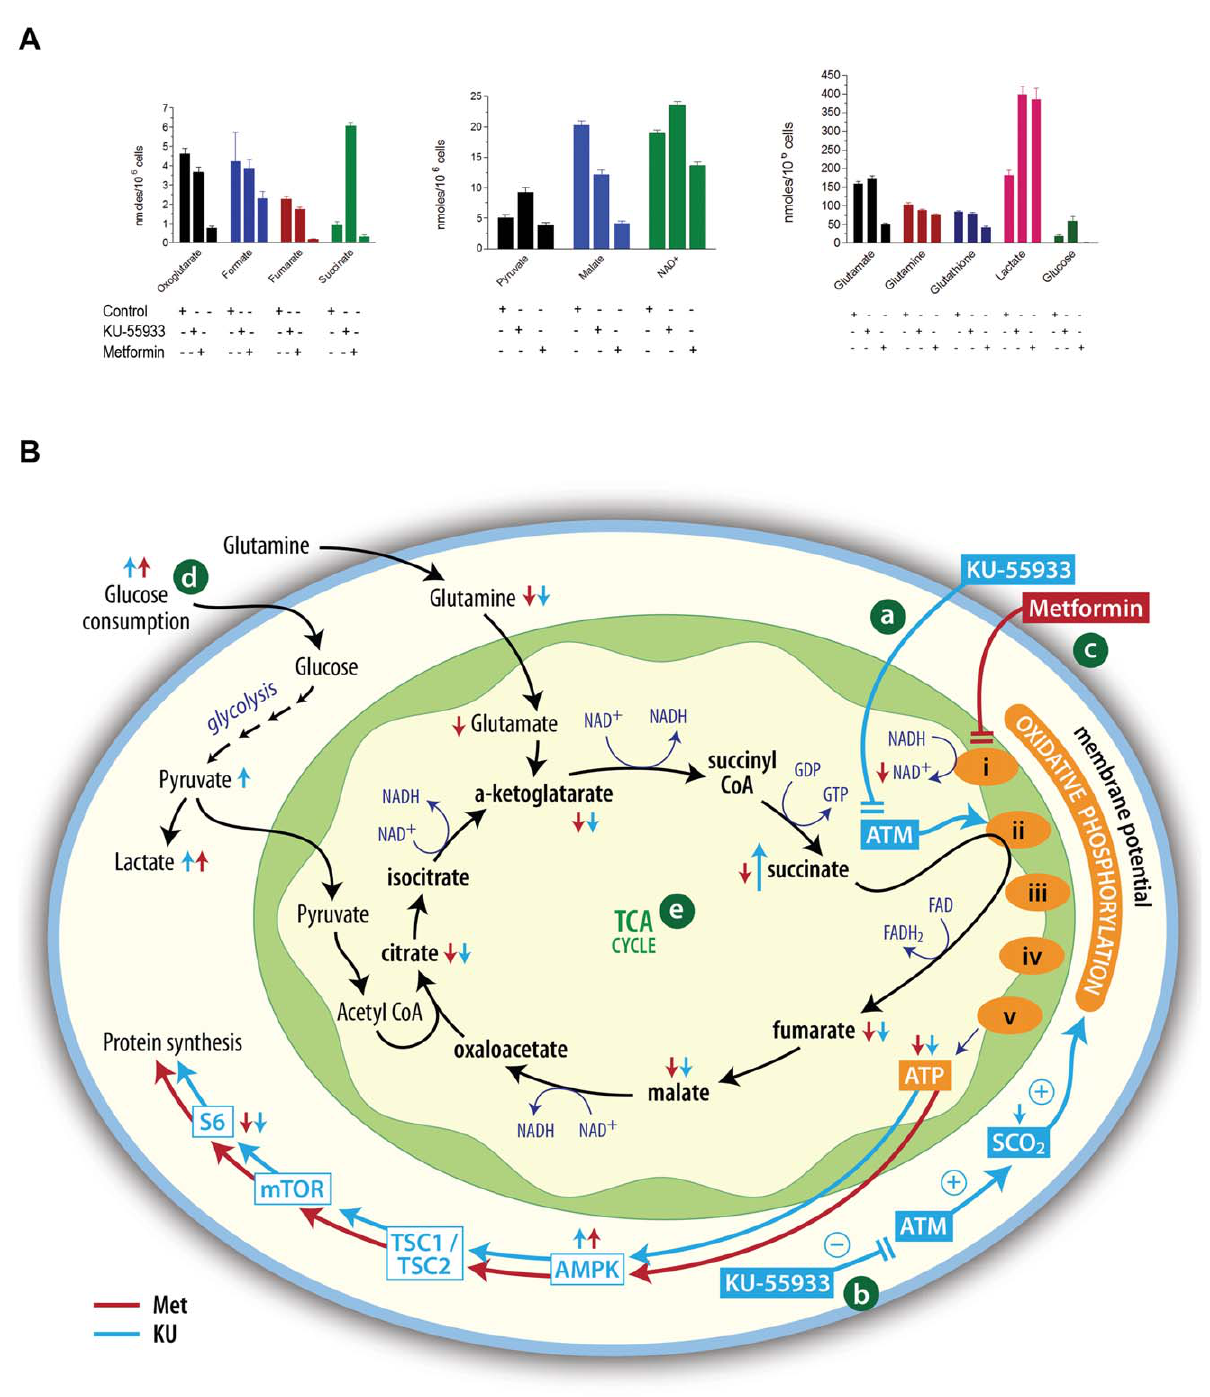
Figure 6. Effects of KU-55933 and metformin on TCA metabolites. ( A ) TCA metabolites were measured by NMR. P values for changes in TCA metabolites are shown in Table S1 ( B ) Interpretation of metabolic changes observed. [a] ATM is hypothesized to have a role in oxidative phosphorylation, effecting respiratory complex II. Therefore, the ATM inhibitor KU-55933 leads not only to reduced ATP production, but also to accumulation of succinate. [b] KU-55933 also may reduce oxidative phosphorylation by a mechanism involving SCO2, as discussed in the text. [c] Metformin acts to inhibit oxidative phosphorylation, but prior evidence together with our findings of decreased NAD + suggest a site of action involving respiratory complex I. [d] Both KU-55933 and metformin exposure lead to increased glucose uptake and lactate production, consistent with a compensatory increase in glycolysis following decreased oxidative phosphorylation. [e] Our observations provide evidence for reduced concentrations of TCA cycle intermediates with exposure to either KU-55933 or metformin, but we postulate different reasons for this: metformin may reduce TCA cycle activity because of a reduction in supply of complex I-generated NAD + , while KU-55933 may act to inhibit conversion of succinate to fumarate. ATM, Ataxia Telangiectasia Mutated protein; SCO2, Synthesis of Cytochrome C Oxidase 2; AMPK, AMP-activated protein kinase; TSC1/TSC2, Tuberous Sclerosis 1/Tuberous Sclerosis 2; mTOR, Mammalian Target of Rapamycin complex 1; rpS6, ribosomal protein S6.